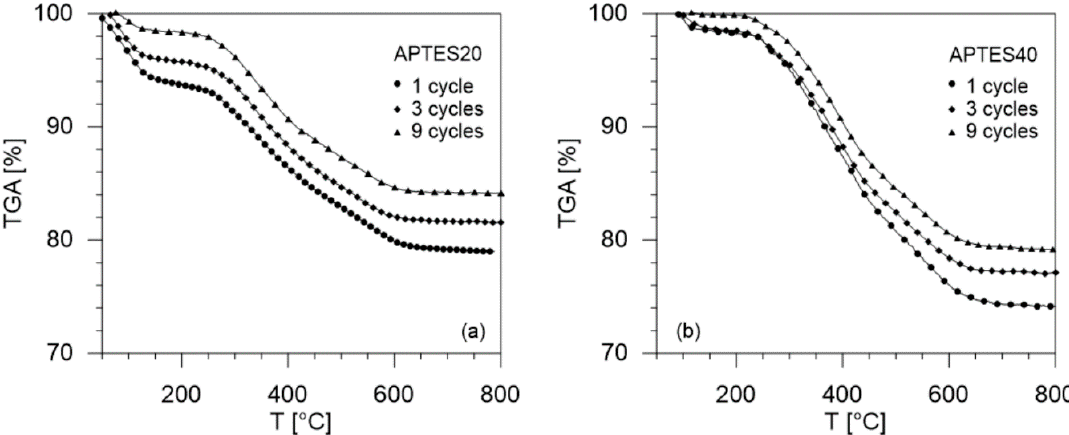
Figure 16. TG analysis for ( a ) APTES20 and ( b ) APTES40 after various cycles of